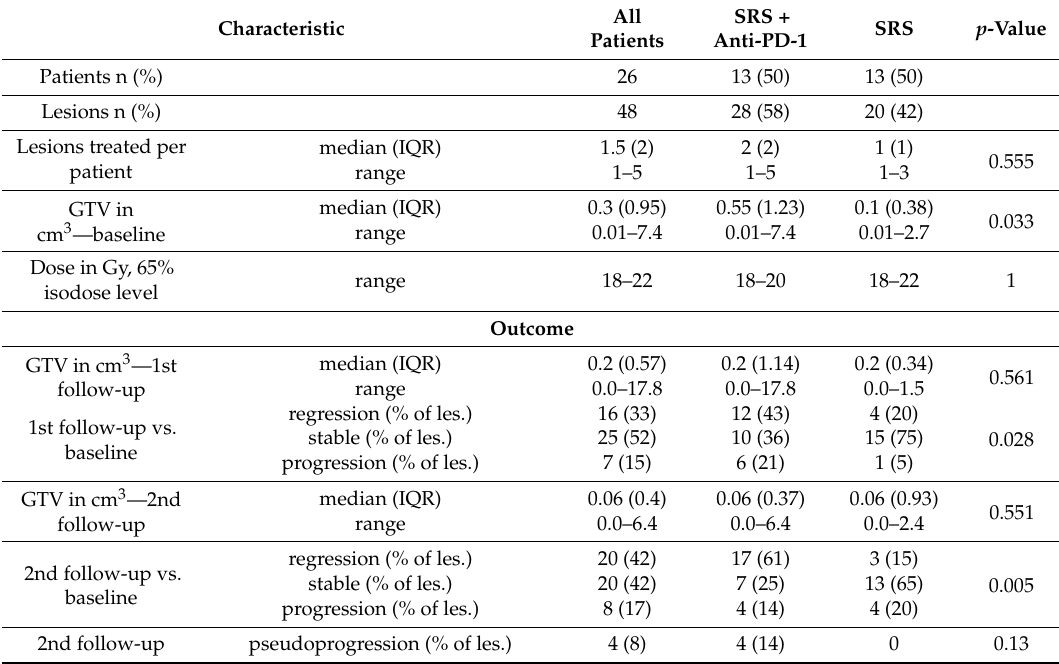
Table 2. Lesion characteristics and outcome.